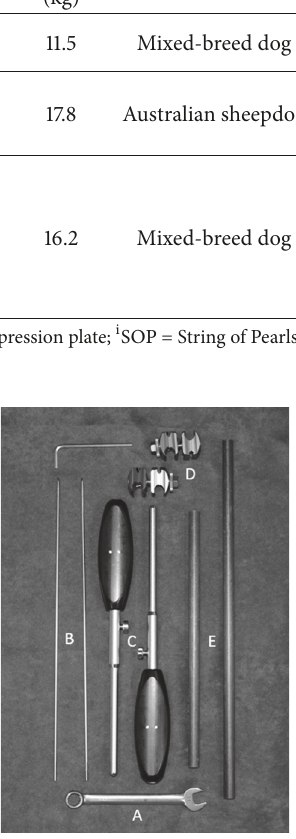
Figure 1: The Minimally Invasive Reduction Instrumentation Sys- tem. A: 8 mm wrench; B: 2.8 mm partially threaded half-pins; C: cannulated reduction handles; D: connecting clamps; E: connecting